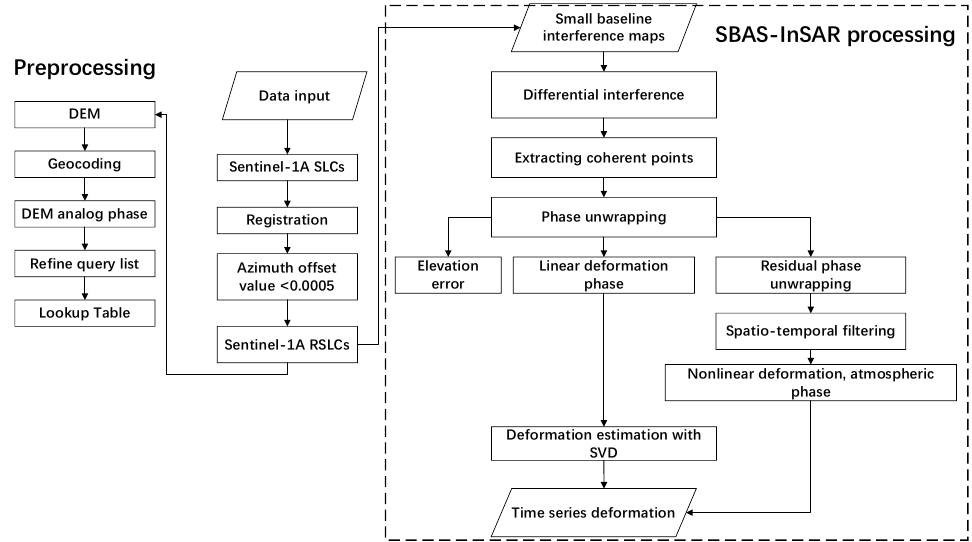
Figure 2. The flowchart of SBAS-InSAR technique.